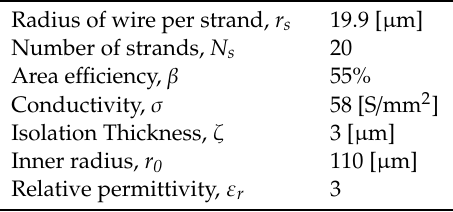
Table 1. Litz wire property.